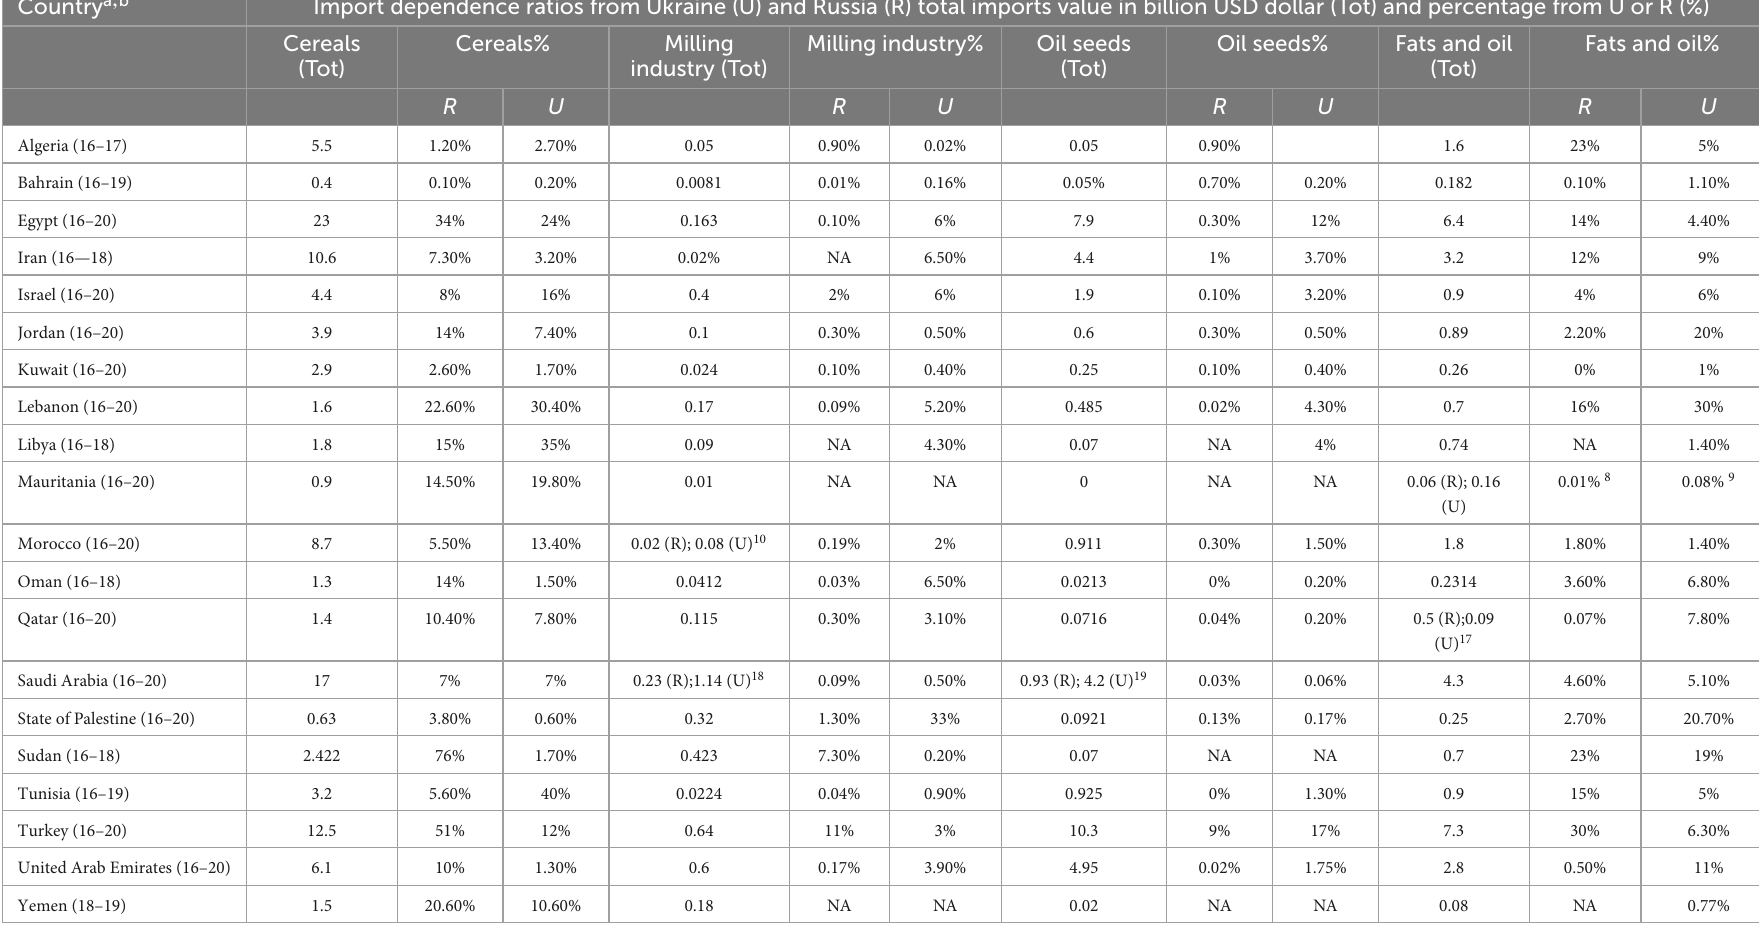
TABLE 2 Import dependence of Middle Eastern countries from Russia and Ukraine (2016–2020) in key food categories. Country a ,